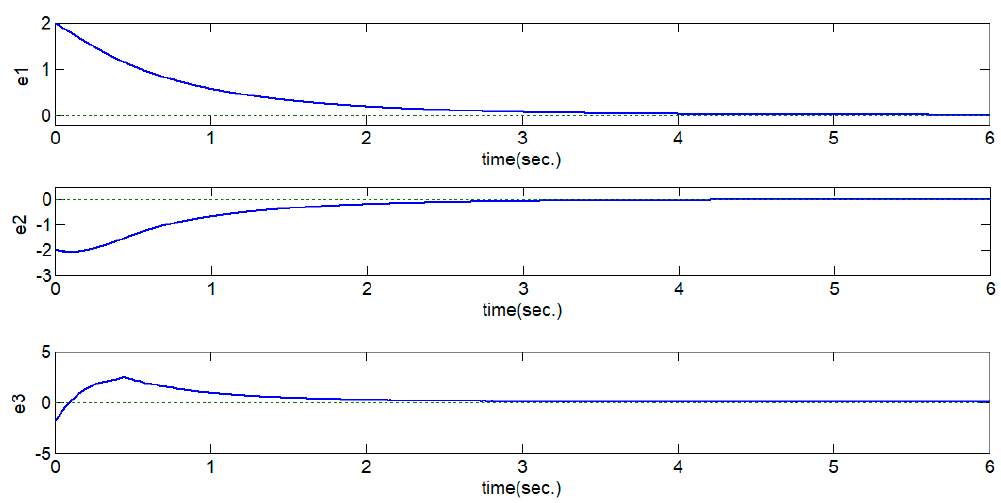
Figure 4. The synchronization error responses (matched condition).